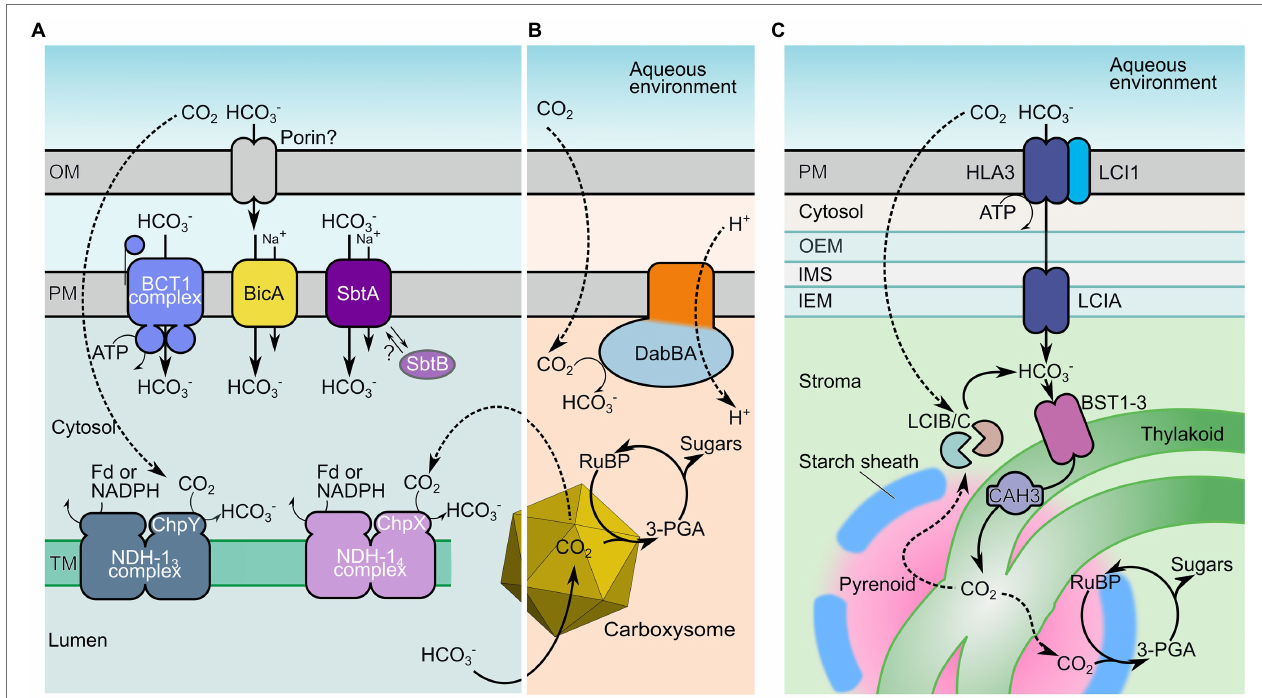
FIGURE 1 | Inorganic carbon uptake components of cyanobacterial, proteobacterial, and microalgal CO 2 -concentrating mechanisms (CCMs). Key inorganic carbon transport mechanisms of cyanobacteria (A) , proteobacteria (B) , and microalgae (C) that facilitate elevated cytoplasmic and stromal HCO 3 − concentrations. The HCO 3 − pool is utilized to generate localized high concentrations of CO 2 in specialized Rubisco-containing compartments knowns as carboxysomes (A,B) or pyrenoids (C) , supporting high carboxylation rates. In cyanobacteria (A) , HCO 3 − is potentially supplied to the periplasmic space via an outer-membrane (OM) porin, and is directly transferred across the plasma membrane (PM) by the single-protein Na + -dependent transporters bicarbonate transporter A (BicA) and SbtA, or by the ATP-driven complex BCT1. In addition, cytosolic CO 2 , acquired by either diffusion, leakage from the carboxysome or spontaneous dehydration of HCO 3 − , is converted to HCO 3 − by the energy-coupled, vectorial CO 2 pumps NHD-1 3 and NHD-1 4 in the thylakoid membranes (TM). In proteobacteria (B) , DabBA plays a similar role, taking advantage of relatively high rates of CO 2 influx from a low-pH external environment to vectorially generate a cytoplasmic HCO 3 − pool (Desmarais et al., 2019). In microalgae (C), HCO 3 − is accumulated via a series of transporters located on the PM (LCI1 and presumably ATP-driven HLA3), the chloroplast inner envelope membrane [inner-envelope membrane (IEM); LCIA] and the TM (bestrophins, BST1-3). Thylakoids traverse the Rubisco-containing pyrenoid where the thylakoid lumen-localized carbonic anhydrase (CA) CAH3 is thought to convert HCO 3 − supplied to the thylakoid lumen to CO 2 . Analogous to the cyanobacterial system, the LCIB/C complex constitutes a putative, vectorial CA that may recycle any CO 2 arising in the chloroplast stroma back to HCO 3 − . Fd, ferredoxin; RuBP, ribulose-1,5-bisphosphate; 3-PGA, 3-phosphoglycerate; SbtB, SbtA regulator protein; and ChpX/ChpY, NDH-1 complex vectorial CO 2 -HCO 3 − domains. Individual transporter proteins are as listed in Table 1